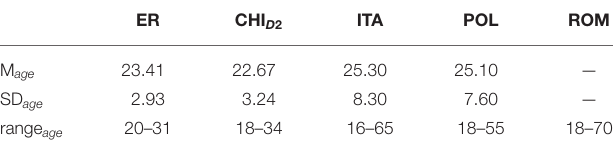
TABLE A1 | Mean, standard deviation, and range of participant age.